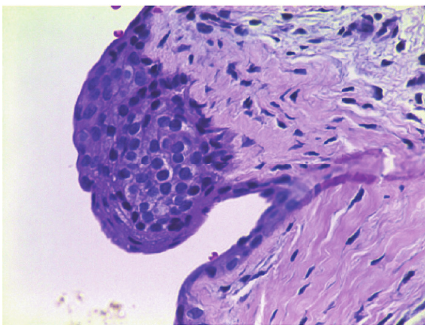
Figure 4: High-power showing in detail a plaque of the epithelial